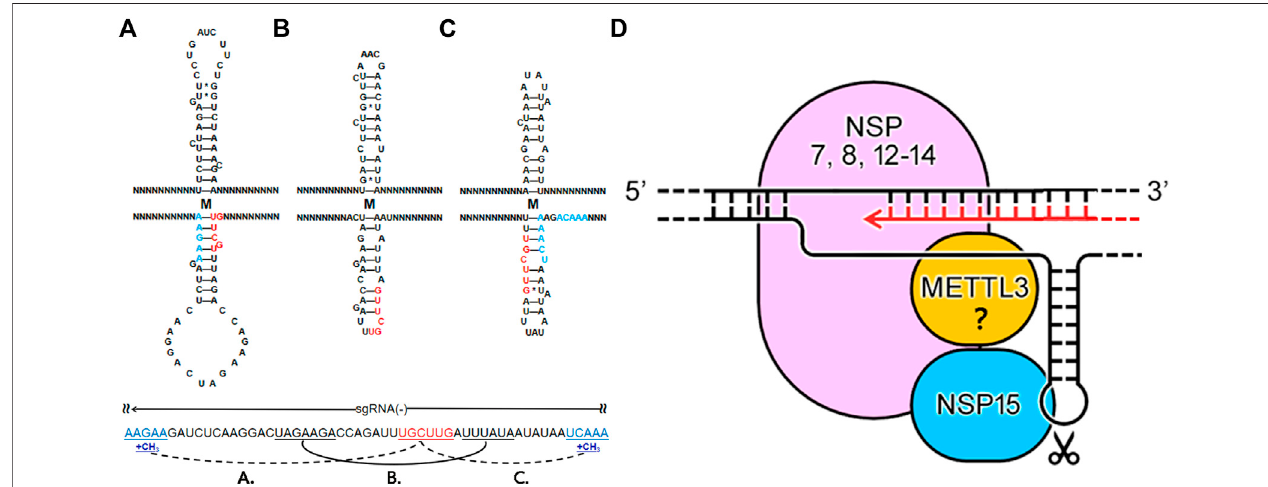
FIGURE 4 | How RTC functions in jumping transcription. N represents any nt. Using the M gene of SARS-CoV-2 as an example, the fi rst (A) and third (C) hairpins requirethe “ AAGAA-like ” orAAACHmotifsinvolvedinthebasepairing.RNAmethylationofsequencescontainingthe “ AAGAA-like ” orAAACH(inbluecolor)motifsisnot in favour of base pairing, ensuring the formation of a unique TRS hairpin (B) containing a NSP15 cleavage site in the loop (D) 5 ′ -3 ′ represents the strand of the SARS- CoV-2 genome. NSP12-14 form the main structure of the RTC; NSP7 and NSP8, acting as the cofactors of NSP12, may be also included in the main structure of the RTC (Yan et al., 2020); NSP15 and METTL3 are coupled with the main structure. The RTC processes the double-strand RNAs (dsRNAs) and single-strand RNAs (ssRNAs) in two situations. Nascent RNAs are synthesized in one route using unwound ssRNAs(+) or ssRNAs(-) as templates. In the other route, ssRNAs(-) can be uncleaved or cleaved for jumping transcription or degraded, which is regulated by a negative feedback mechanism (Li et al., 2021a). NSP15 cleaves a ssRNA in a small loop in the second route.